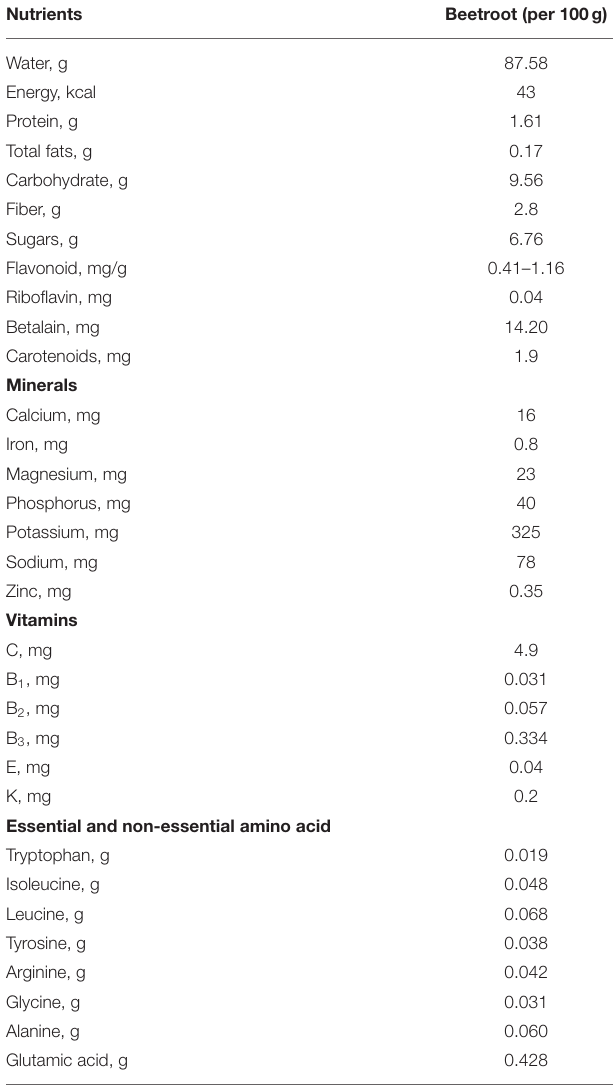
TABLE 1 | Nutrient composition of raw Beetroot (per